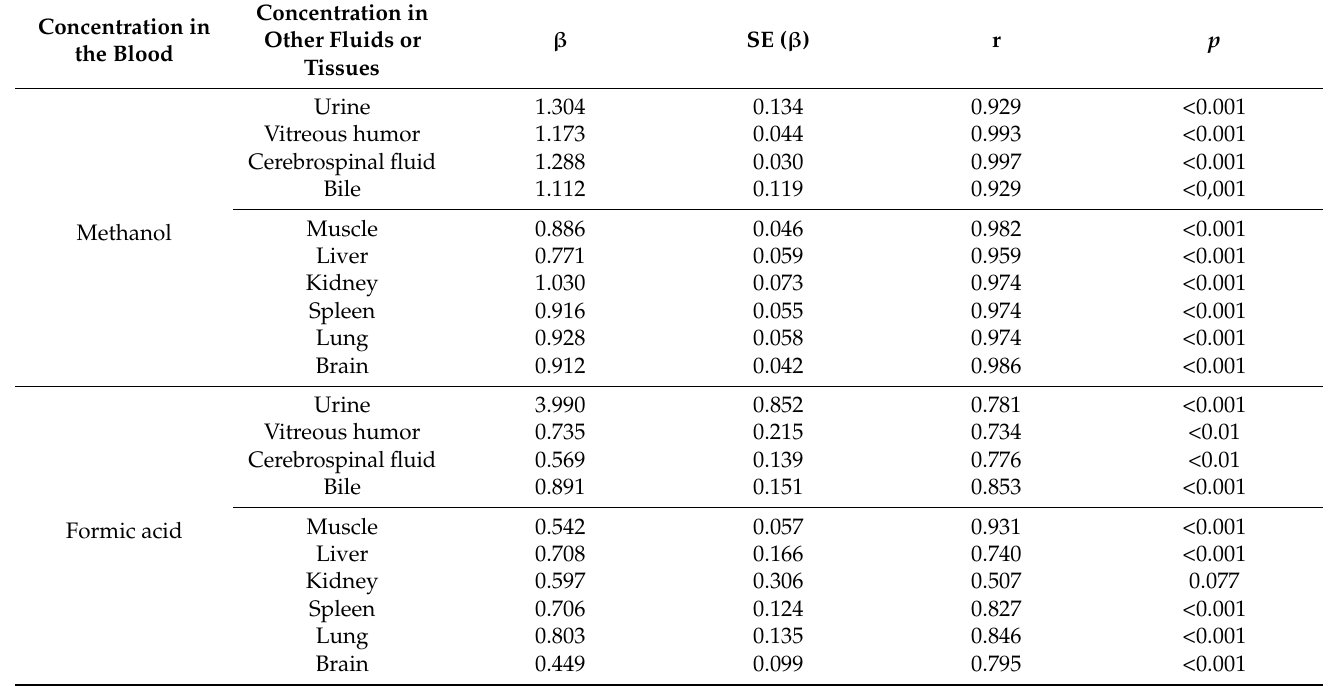
Table 2. Analysis of univariate linear regression for methanol concentration in blood and other body fluids and tissues of fatal methanol poisoning victims.